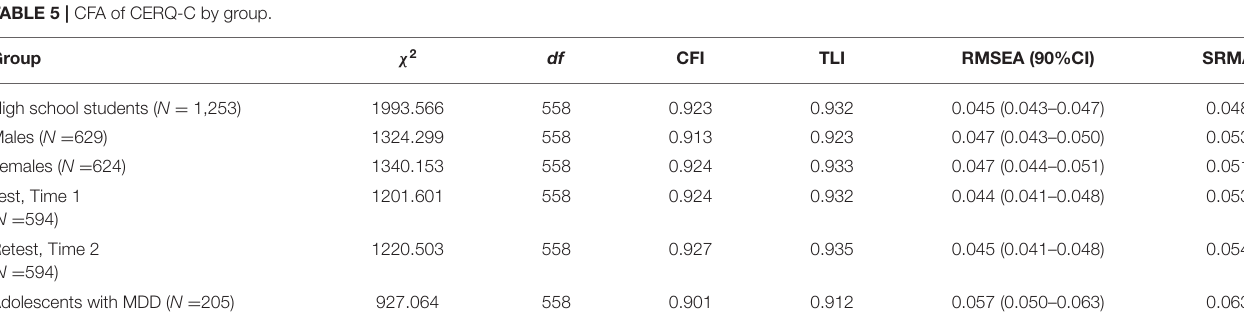
TABLE 5 | CFA of CERQ-C by